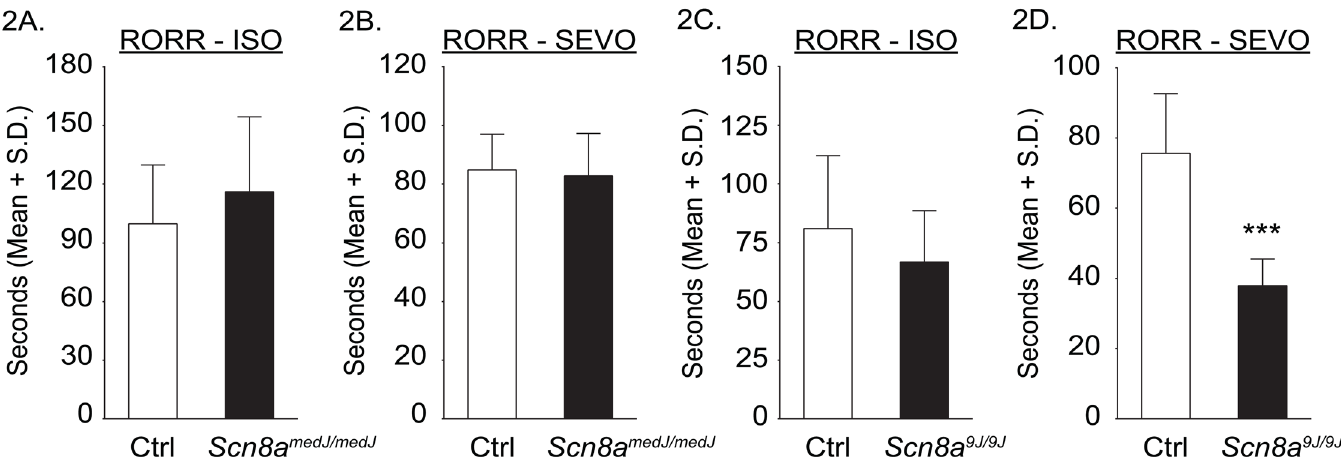
Fig 2. Effect of Scn8a medJ and Scn8a 9J mutations on the time to emergence from isoflurane and sevoflurane anesthesia. Compared to the littermate control mice, there was no significant difference in the time to emergence — return of righting reflex (RORR) — from isoflurane anesthesia (ISO) for either Scn8a medJ/medJ (A) or Scn8a 9J/9J (C) mice, or from sevoflurane anesthesia (SEVO) for Scn8a medJ/medJ (B) mice. The mice with Scn8a 9J mutation (D) emerged significantly faster from sevoflurane anesthesia. Seven mice were used for each group. Data were combined from two trials for each anesthetic and for each mouse. *** p = 0.0002 compared to littermate control mice (Ctrl). S.D. — standard deviation.